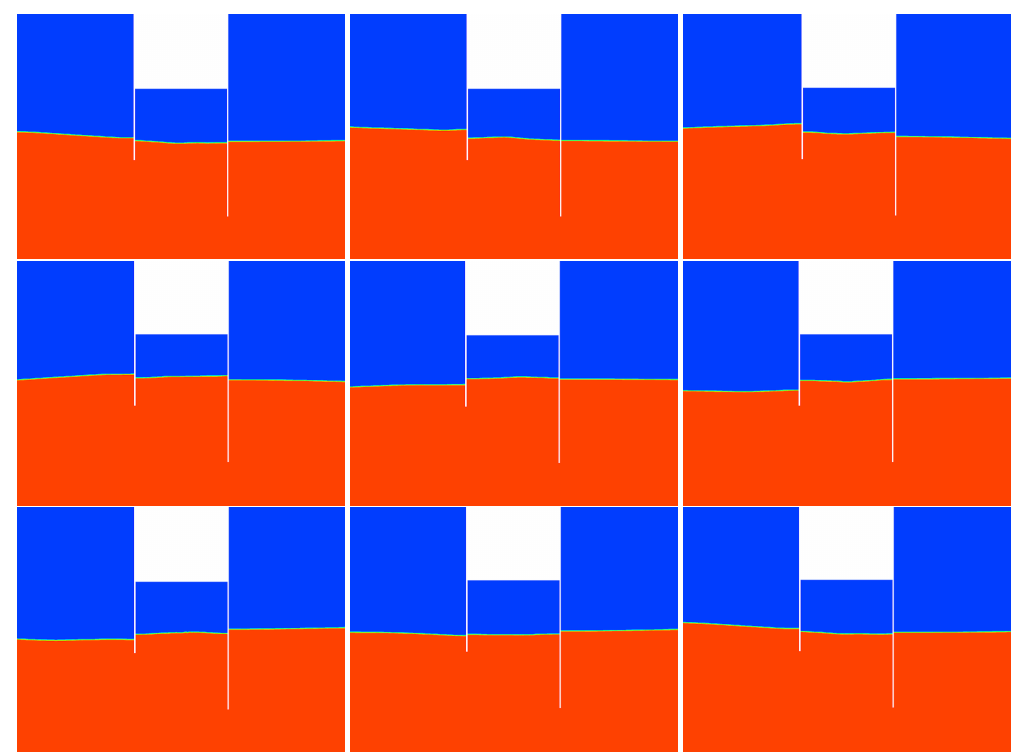
Figure 18. Instantaneous free surface flow near the OWC device along one wave period.